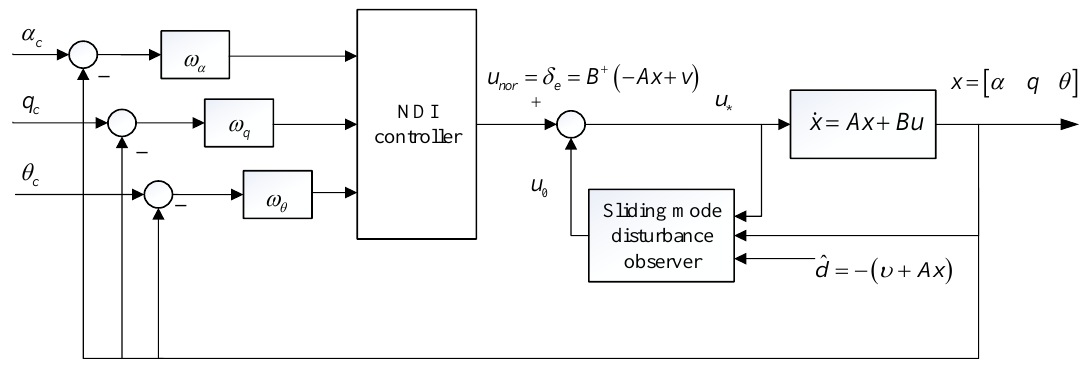
Figure 3. Longitudinal HFV model sliding mode NDI controller.